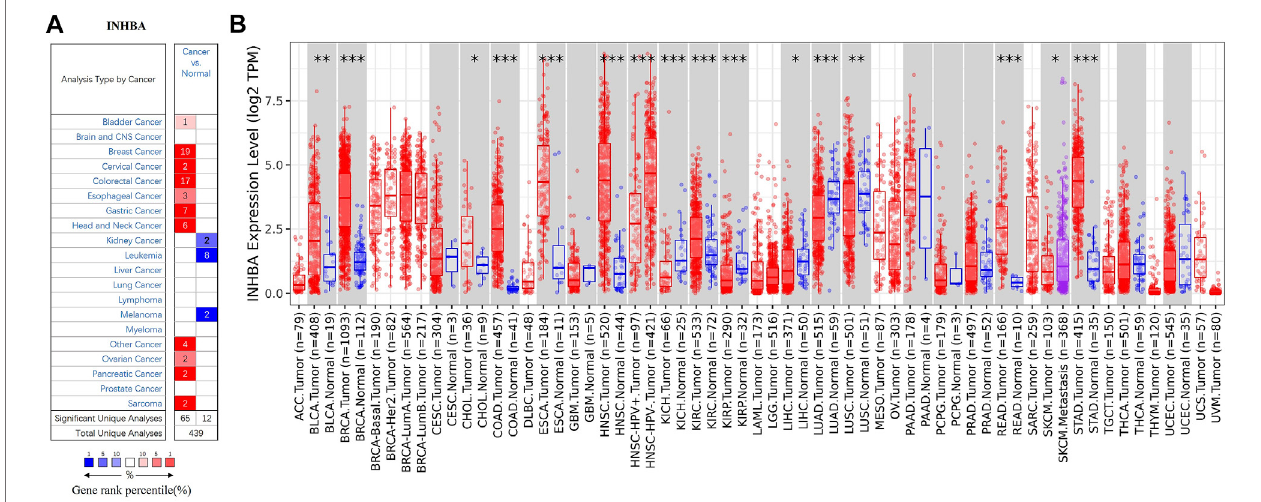
FIGURE 1 | mRNA expression of INHBA in different types of human cancers. (A) Increased or decreased expression of INHBA in datasets of different cancers compared with normal tissues in Oncomine database. Number in each cell is amount of datasets. (B) Human INHBA expression of different tumor types from TCGA database was determined by TIMER2.0 (* p < 0.05, ** p < 0.01, *** p <